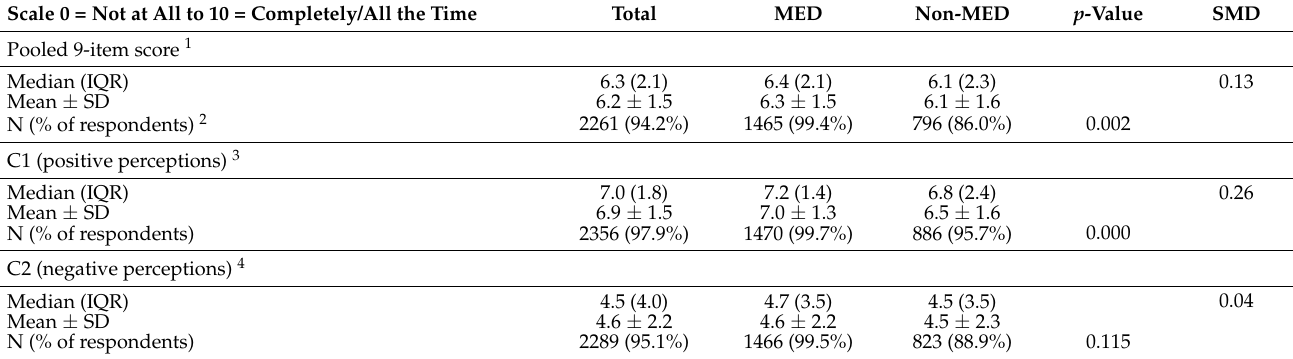
Table 5. Pooled 9-item score and components C1 and C2: total population, MED and non- MED